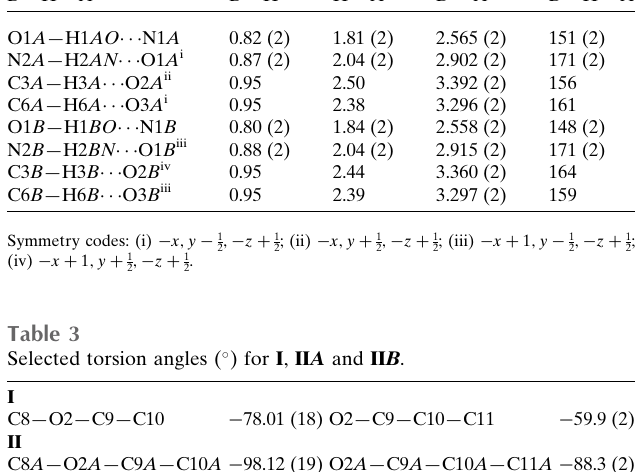
Figure 1 An ellipsoid plot (50% probability) of I , showing the intramolecular hydrogen bond (O1—H1 O (cid:2)(cid:2)(cid:2) N1) as a dashed line.